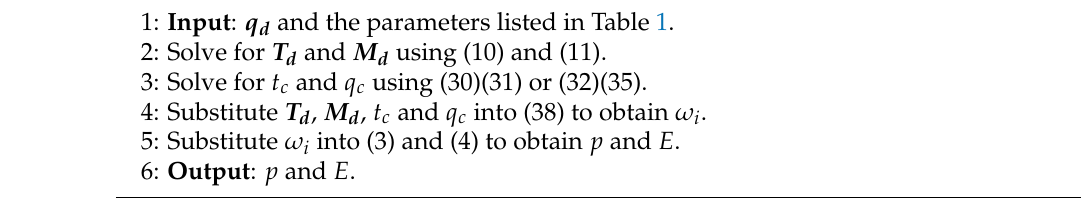
Algorithm 1 Trajectory-based quadrotor UAV’s energy-consumption calculation.